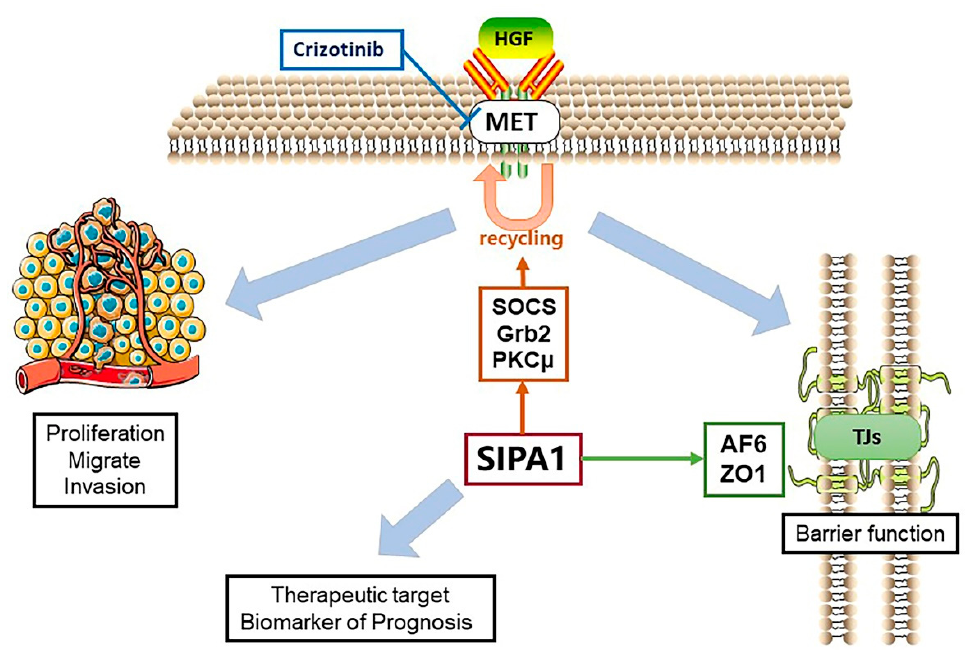
Figure 8. Diagram of the overview of this study. Schematic indicating the possible regulatory path- way for SIPA1 in lung cancer cells and the control of TJ function and assembly by HGF.